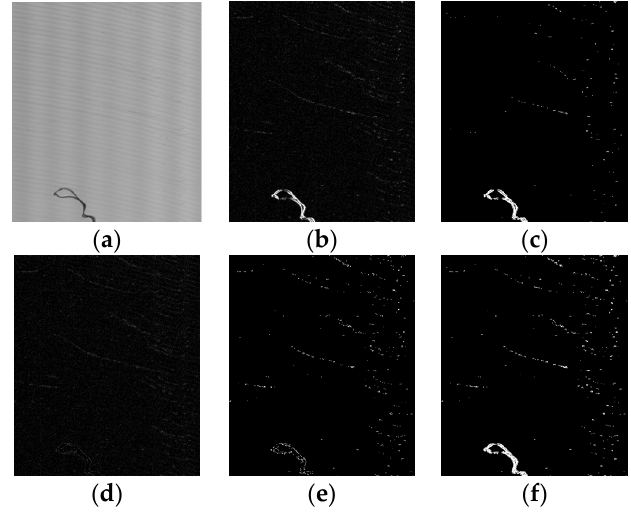
Figure 5. Iterative threshold segmentation of gradient map: ( a ) original image; ( b ) gradient response map (Original Gradient, or OG); ( c ) response map of the first threshold segmentation; ( d ) mask gradient (MG1) after the first threshold segmentation; ( e ) response map of the second threshold segmentation; ( f ) the final segmentation result.